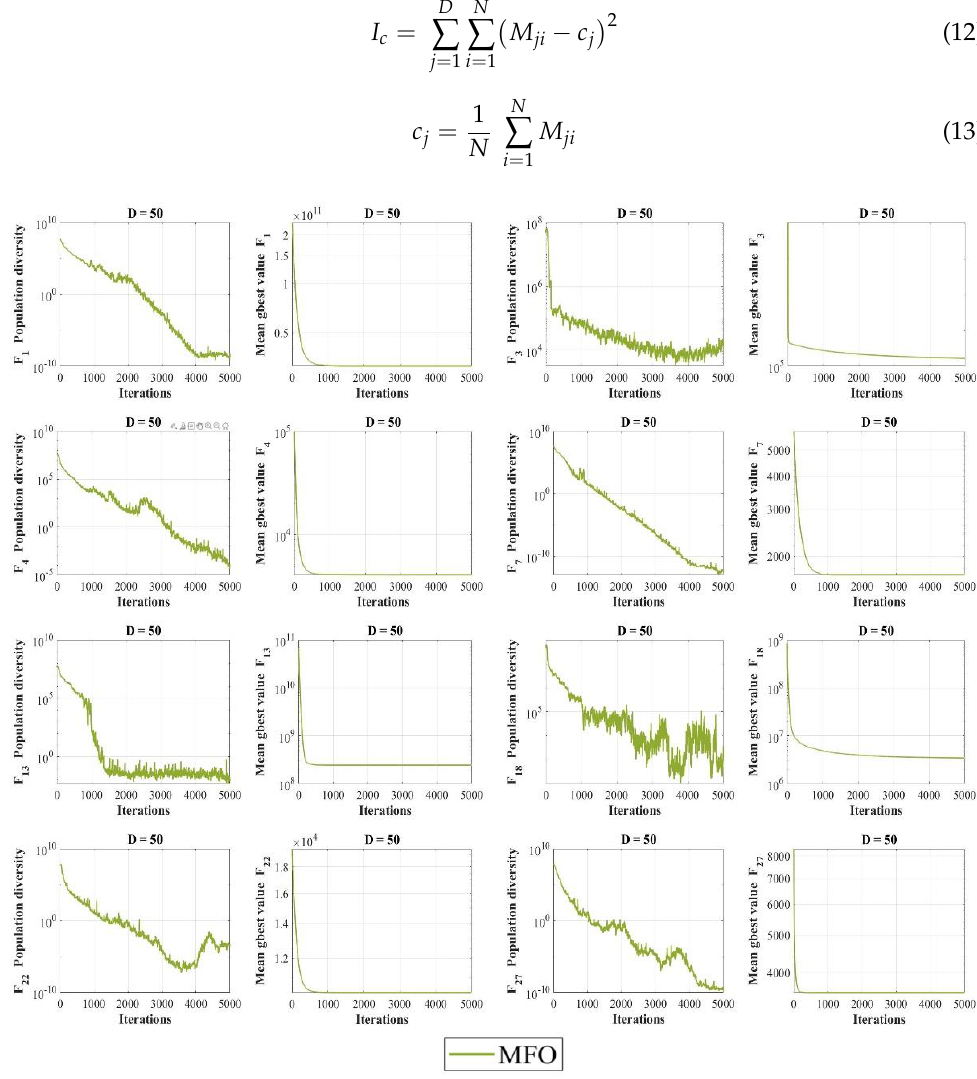
Figure 3. The diversity and convergence curves of the MFO.